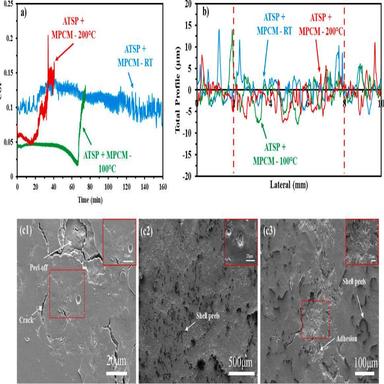
Tribological performance of ATSP + MPCM durability tests at RT, 100, and 200 ◦C. (a) In-situ COF against time, (b) 2D wear profilometric scans, and (c) SEM images of worn surfaces. High magnification images are shown as insets.